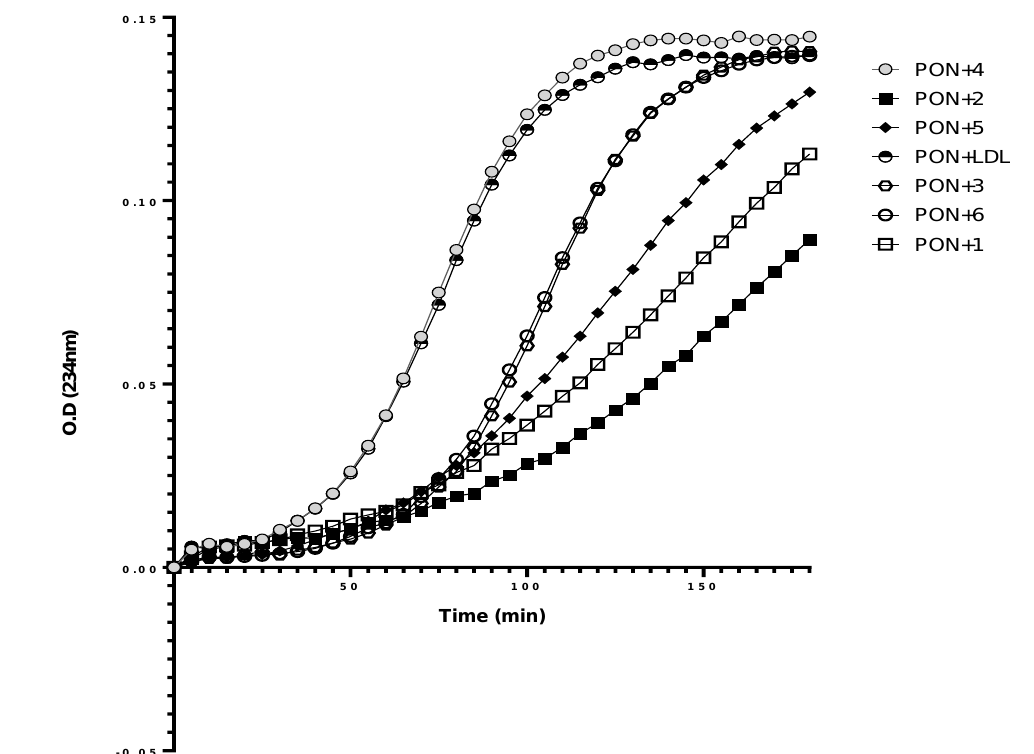
Figure 7. Effect of bioactive lipids on the oxidation of LDL induced by Cu 2+ . ( A ) The synthesized exogenous lipids 1–6 and ( B ) The purchased endogenous lipids 7–10. Conjugated diene formation during copper-mediated LDL oxidation was monitored for 180 min for changes in absorbance at 234 nm. Each experiment was repeated separately three times. Results are presented as mean ± SD. See Figure 1 for compounds corresponding to each number.